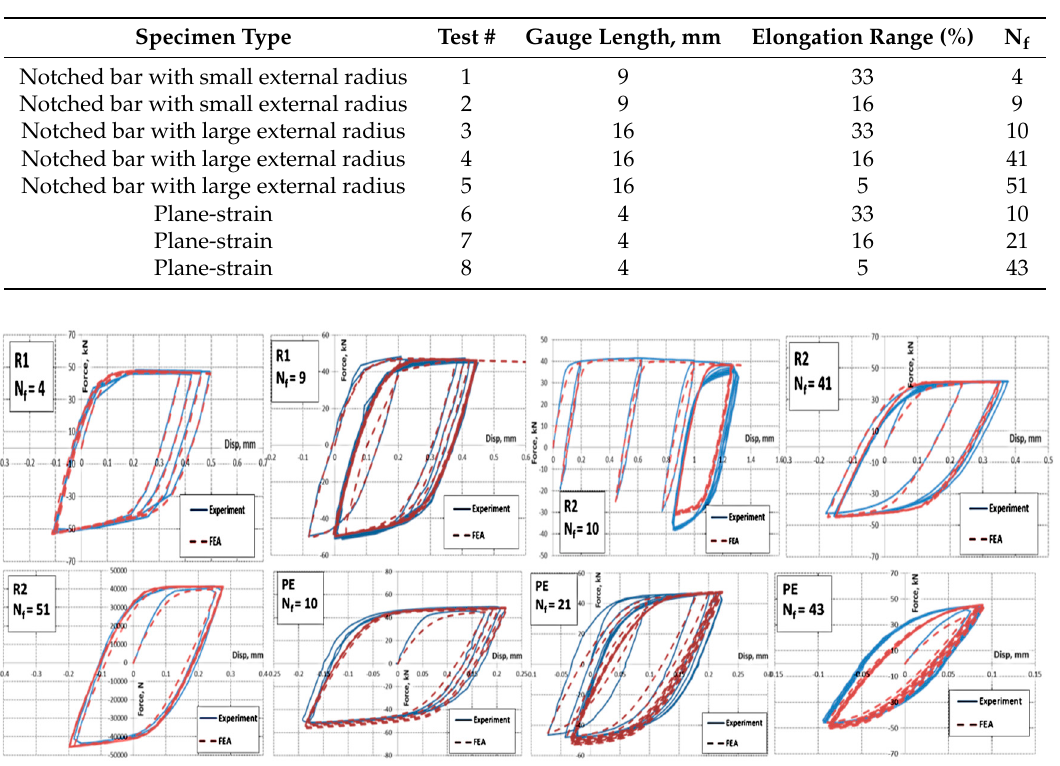
Figure 6. The FEA simulations (in red and dashed line) of the experimental force–displacement hysteresis loops (in blue) for different stress states. Reproduced from Reference [1], with permission from Elsevier, 2019